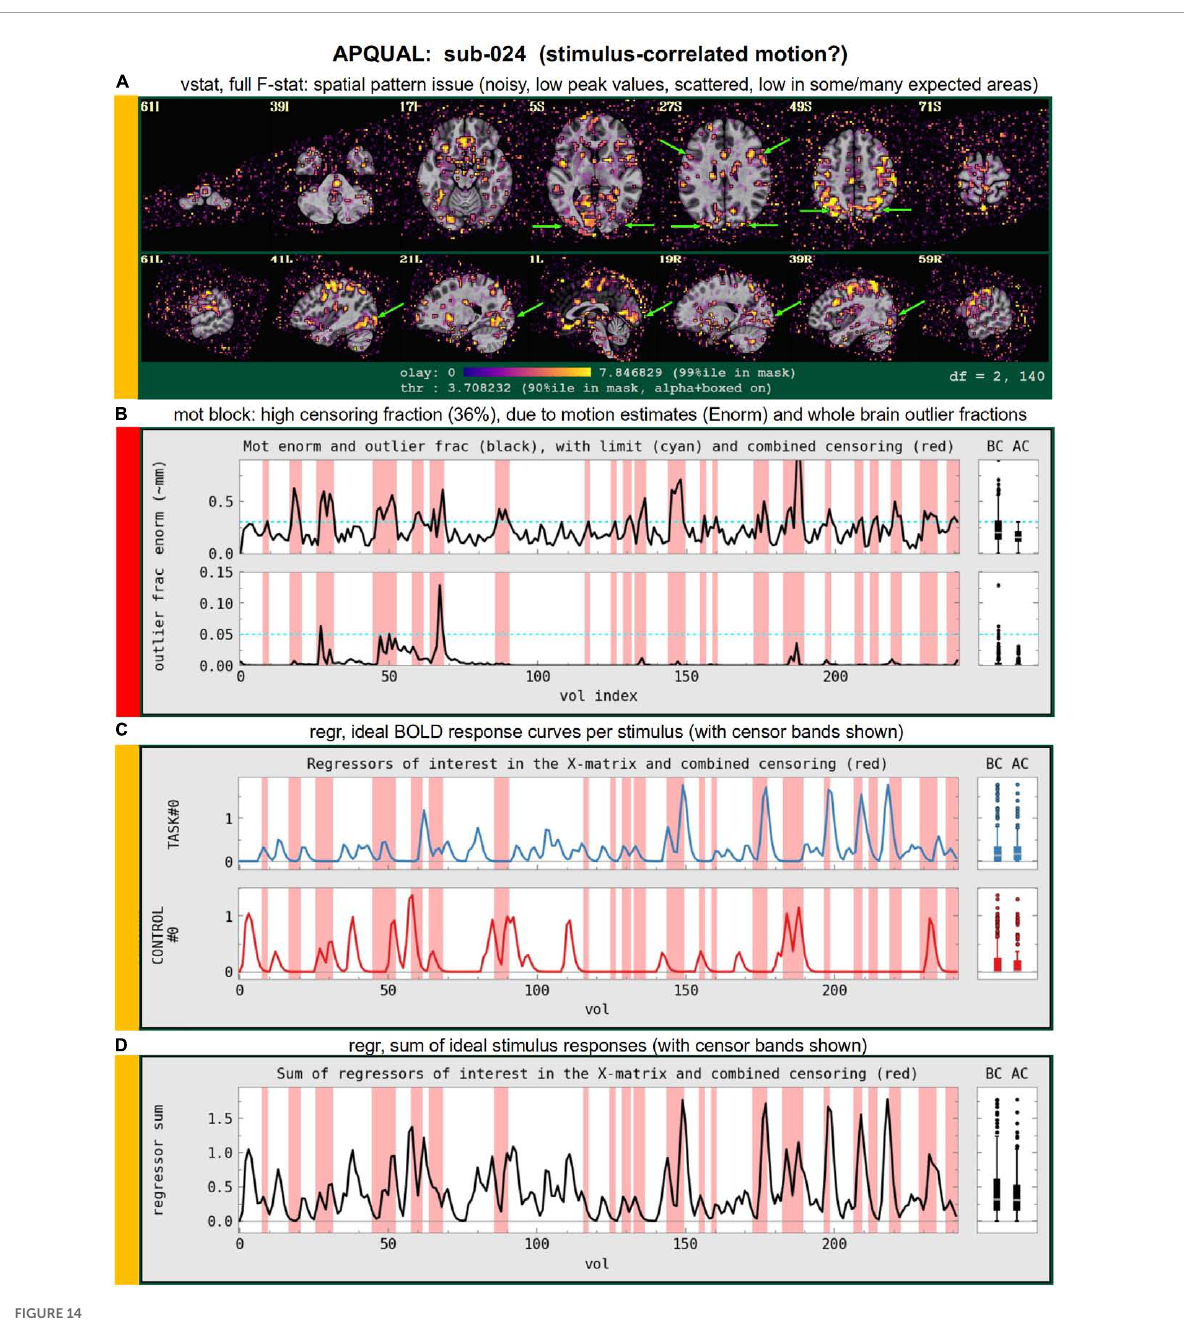
FIGURE14 Combining APQUAL blocks: vstat (see Figure 12 ), mot (for combined motion estimates and censoring), and regr block plots of stimulus responses. The full F-stat map for sub-024 in panel (A) is noisy and shows relatively poor model fitting across the brain (cf Figures 12A, D ). In trying to understand more about this subject’s data, the motion estimate responses are shown in panel (B) , where a large fraction of time points have been censored ( > 36%; shown in the red bands). Furthermore, in viewing the locations of censoring with respect to the ideal stimulus response curves for this subject [panels (C,D) ], one sees that much of the motion appears to occur during many of the stimulus events. Thus, it is possible that this subject exhibits stimulus-correlated motion, which is particularly difficult to remove with